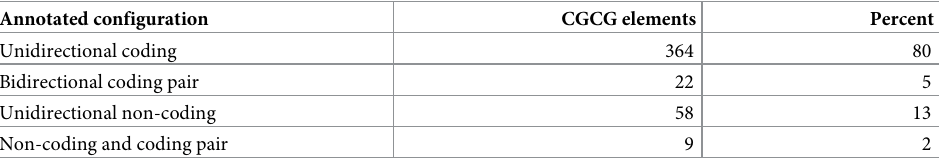
Table 2. Occurrence of CGCG elements in the annotated human